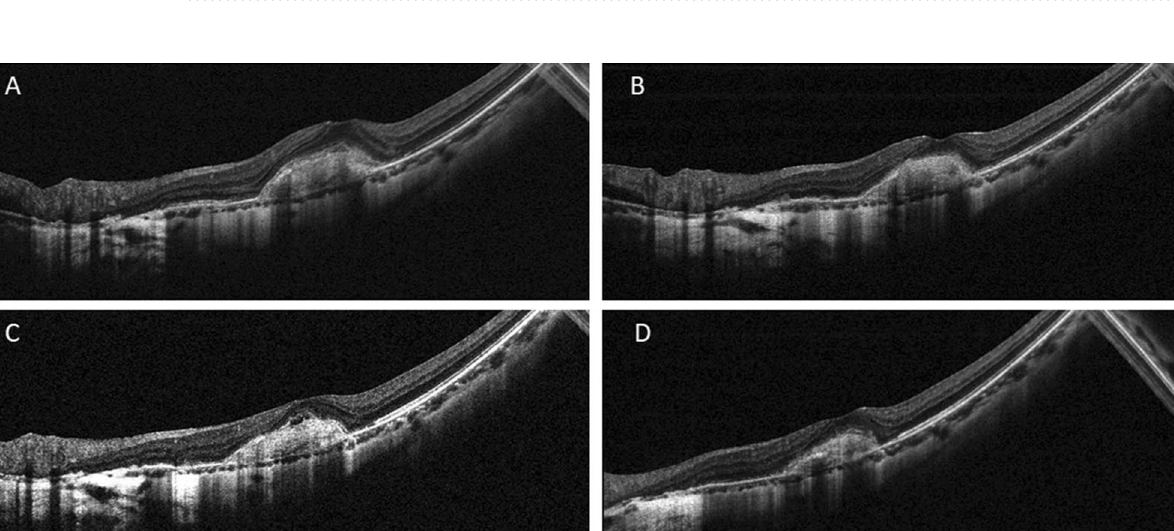
Table 3. Linear regression analysis for final BCVA of mCNV patients aged over 50 years treated by Conbercept at 1-year follow-up. Adopted stepwise selection. BCVA best-corrected visual acuity, CMT central macular thickness, CNV choroidal neovascularization, ELM external limiting membrane, IRF intraretinal fluid, EZ IS ellipsoid zone, logMAR logarithm of the minimum angle of resolution, SFCT subfoveal choroidal thickness, SRF subretinal fluid.